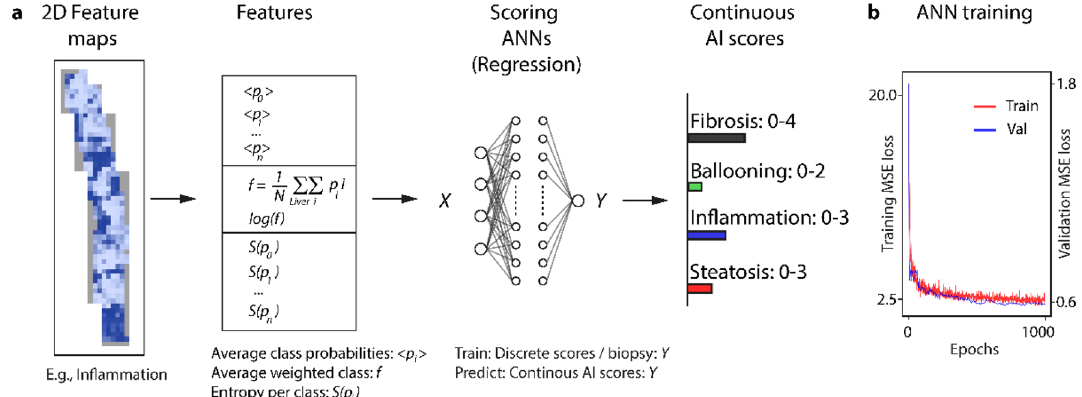
Figure 5. Aggregation of 2D histological feature maps to obtain continuous AI-based Kleiner & Brunt scores. ( a ) For each score distributed features (left) are converted into average class probabilities, average weighted classes, and entropies per class (second column from left). These values are used as input for a dedicated ANN that trained to predict the pathologist scores from the input with minimized deviation (third column from left). The ANN output has the same range as the Kleiner and Brunt score and is therefore directly interpretable. In contrast to scores from human experts, it generates continuous-scaled outputs, for example to account for transitions two discrete scores. ( b ) Training curves of the ANN show the decrease of the mean squared error (MSE) loss during training. The MSE quantifies the deviation of pathologist ground truth and ANN predictions.